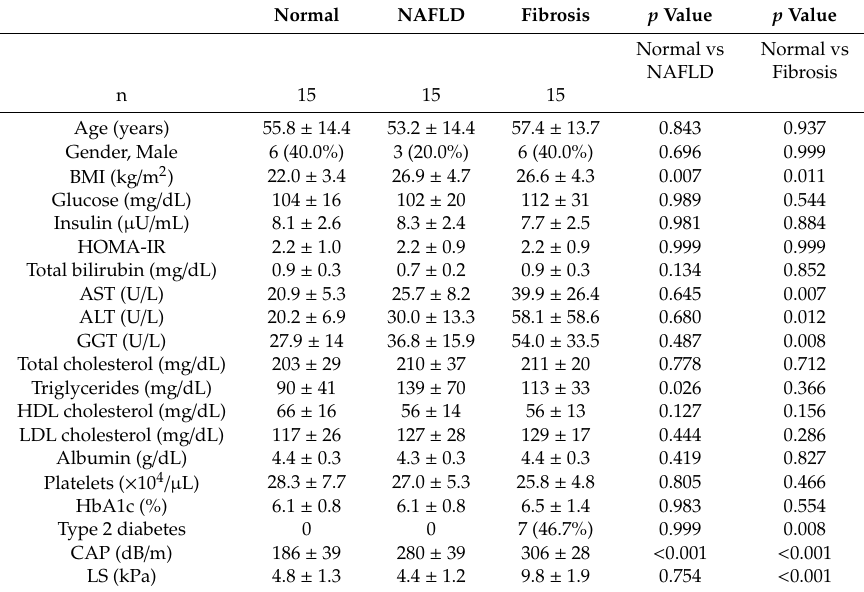
Table 4. Participants’ characteristics after matching for insulin